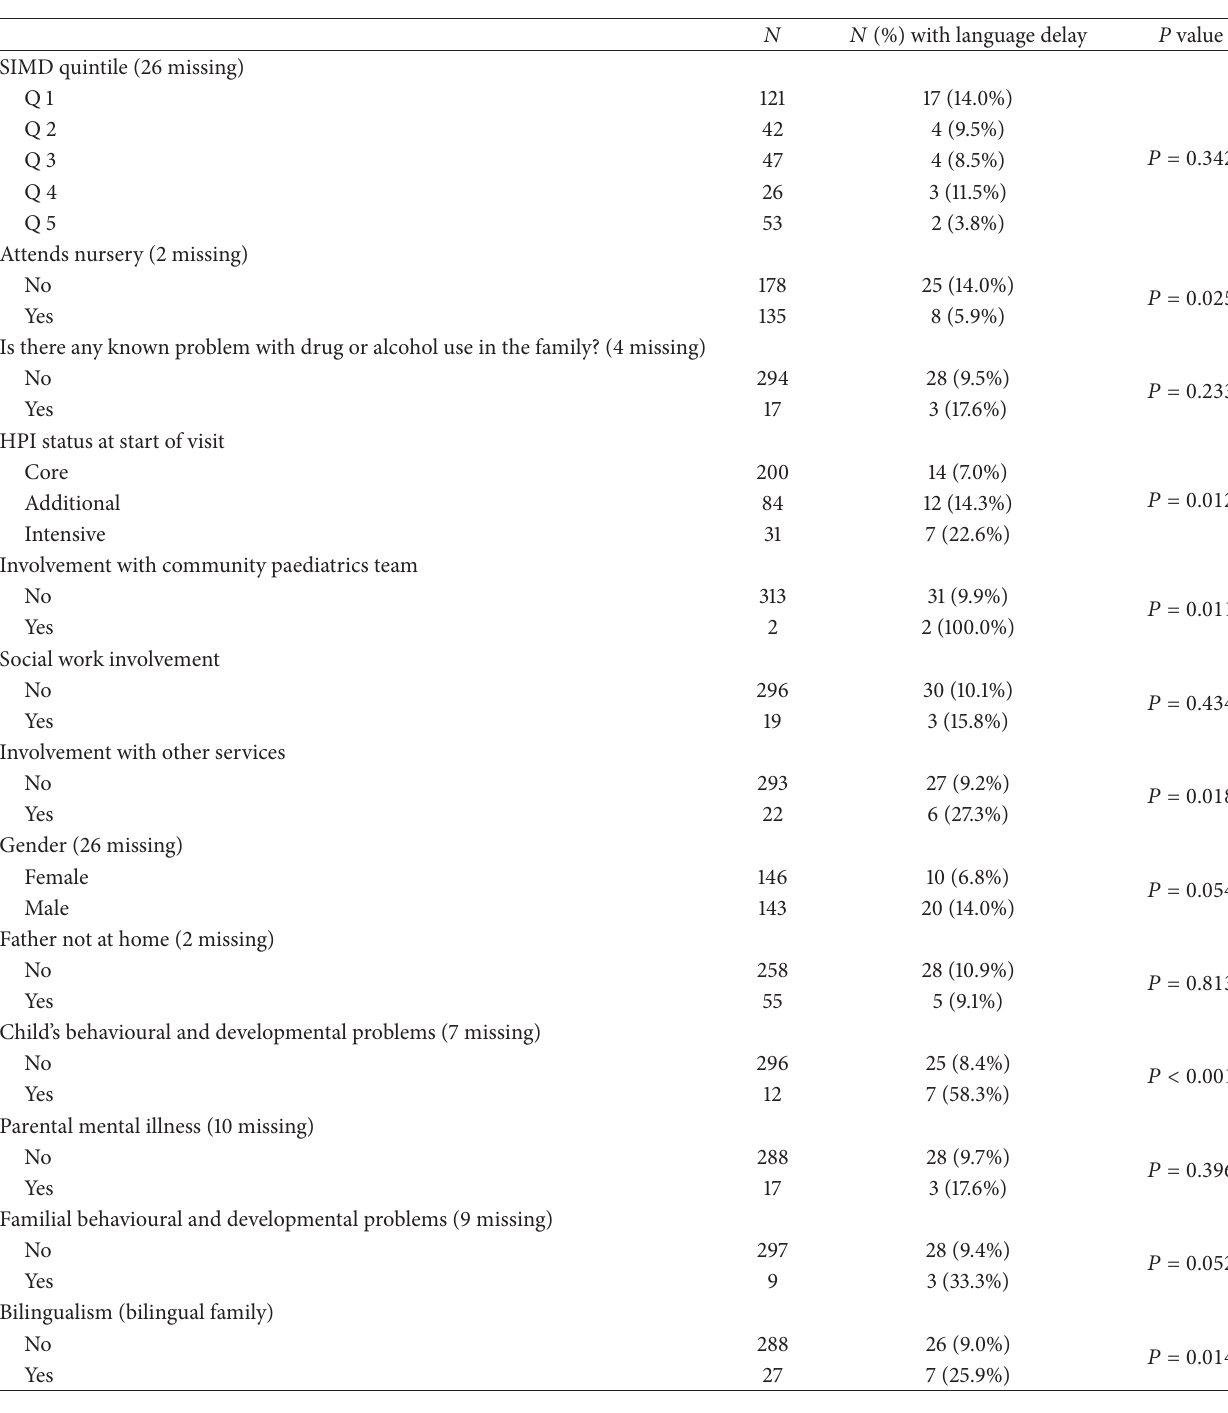
Table 1: Univariate analysis. Prevalence of language delay at 30 months in relation to potential risk factors, with Fisher’s exact test 𝑃 values. 𝑁 𝑁 (%) with language delay P